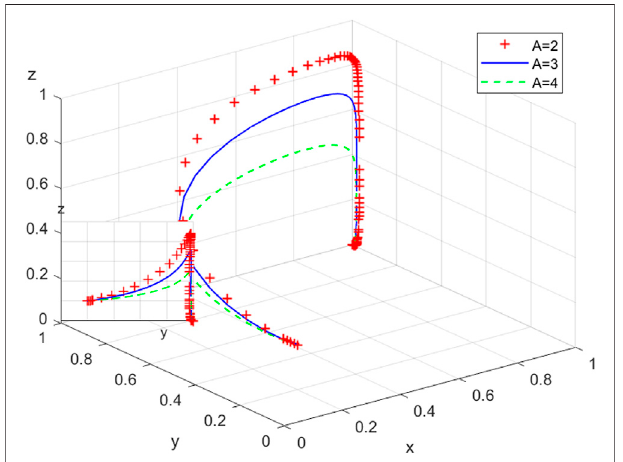
FIGURE11| ImpactoftheCP ’ sparticipationcost ontheevolutiontrack of the tripartite evolutionary game.